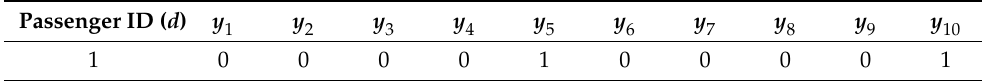
Table 11. Solution y for